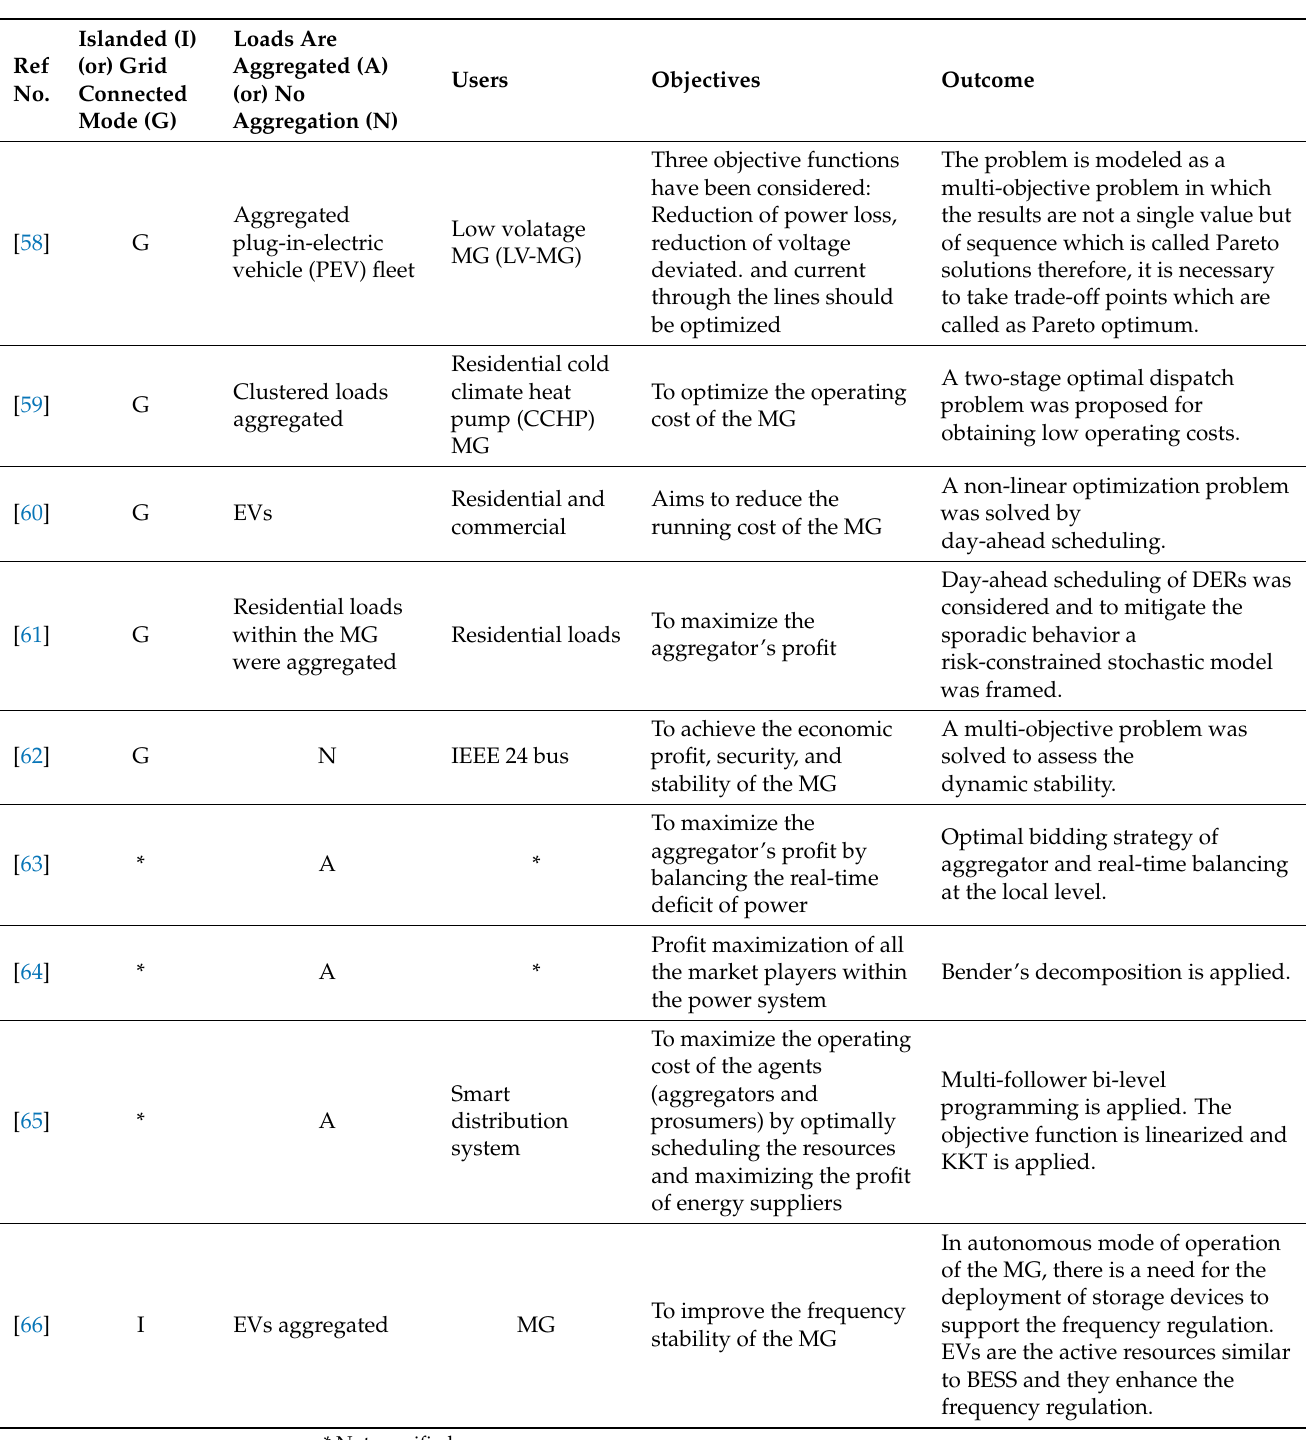
Table 4. Need for aggregator